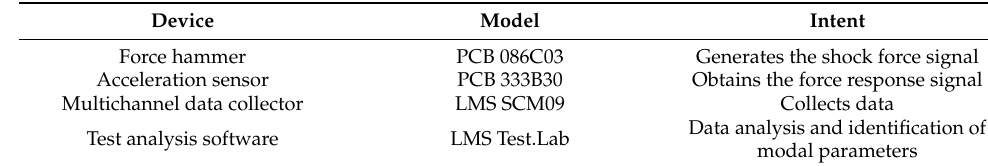
Figure 5. Sensor layout position and experimental site. Table 1. Modal experimental equipment.